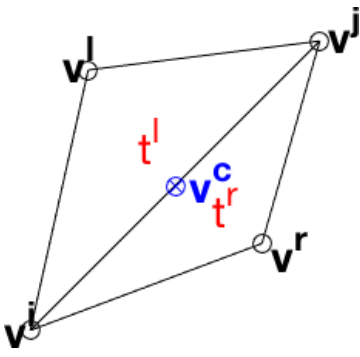
Figure A3. A very simple mesh, showing the staggered vertex v c connecting vertices v i and v j